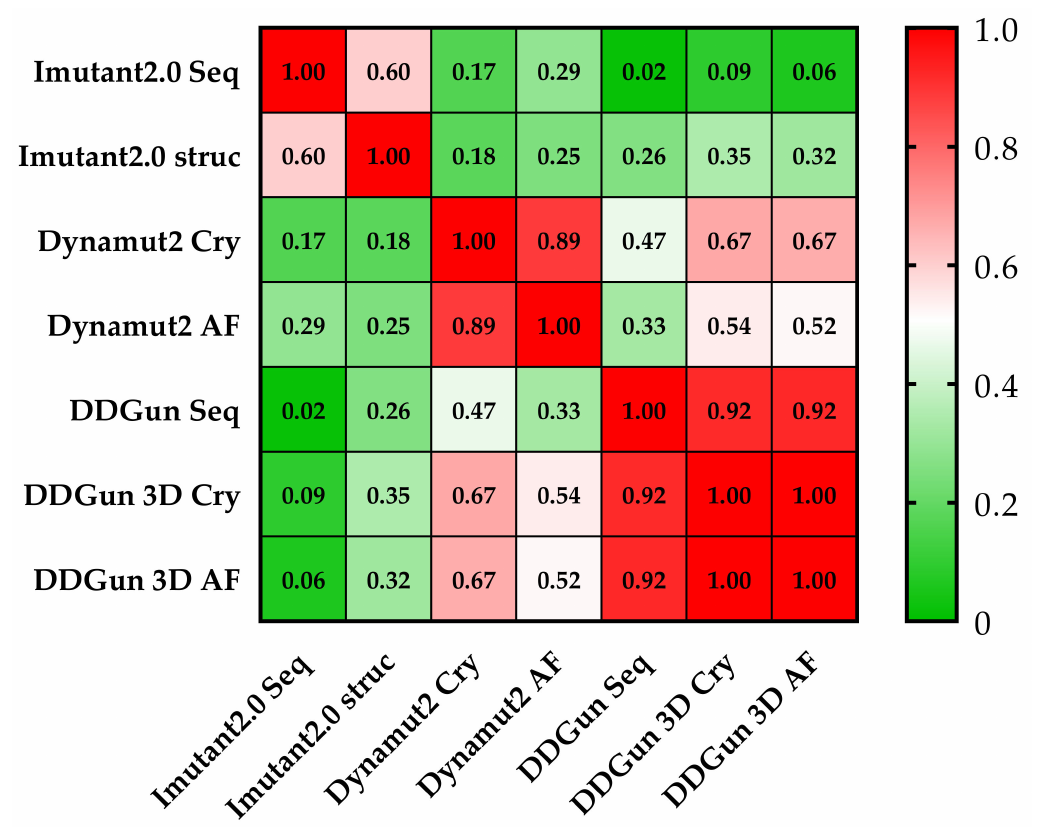
Figure 7. Pearson correlation matrix of the seven prediction methods. None of the results obtained by the I-Mutant 2.0 analyses showed a correlation of (<0.5 Pearson’s r was observed) with the results of other methods. The cells of the table are colored based on Pearson’s r values (see color scale). The other sequence-based method DDGun seq even with its DDGun pairs is highly correlated with DynaMut2 methods not reaching